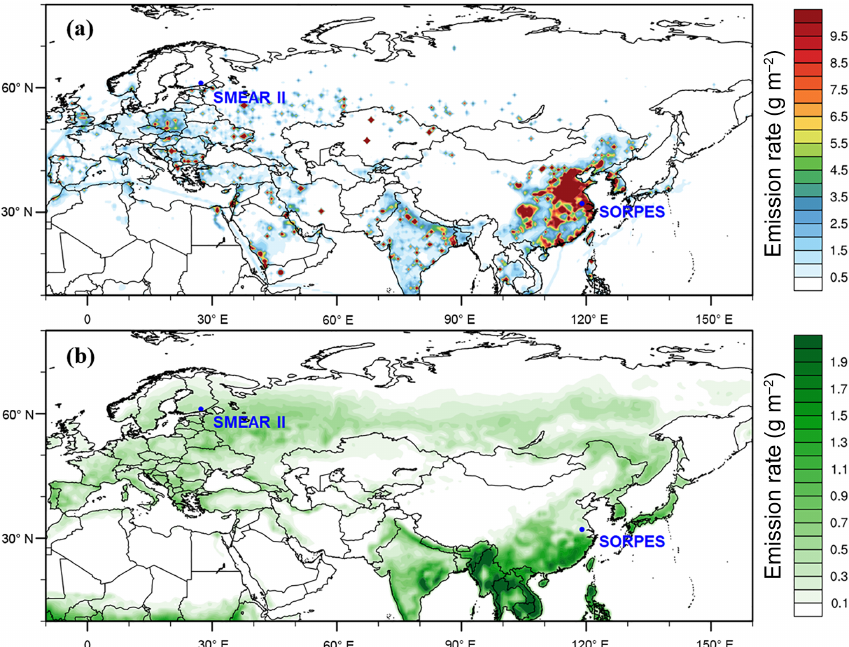
Figure 1. Site (SMEAR II and SORPES) locations on a map of the emission inventory of (a) SO 2 and (b) monoterpenes (Sindelarova et al., 2014; Granier et al., 2011) (emission inventory data are available at http://eccad.aeris-data.fr, last access: 1 August